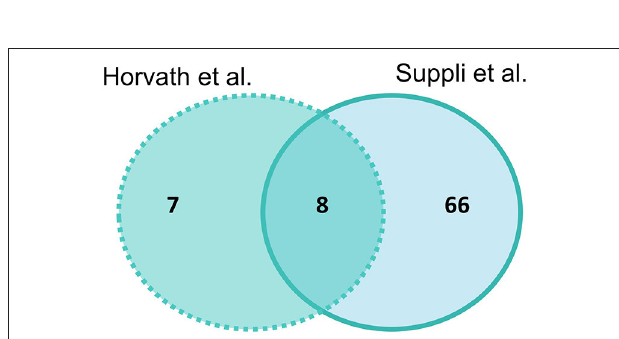
FIGURE 3 | Venn diagram of number of significantly differentially expressed genes (adjusted P -value < 0.05) in liver samples of healthy obese controls vs. NASH. Light blue indicates Suppli et al. (29), aqua indicates Horvath et al. (31).